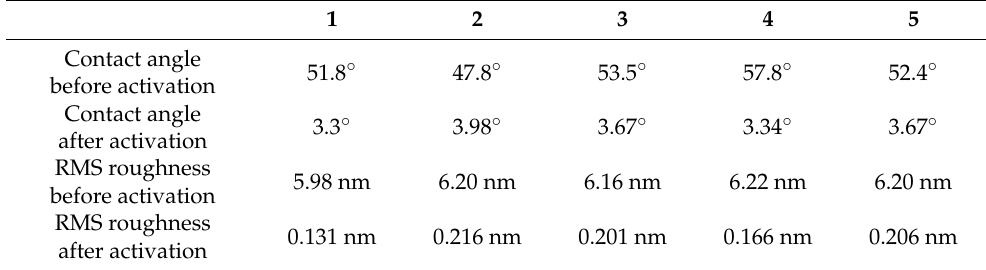
Table 2. Contact angle and RMS roughness of SiC wafer before and after